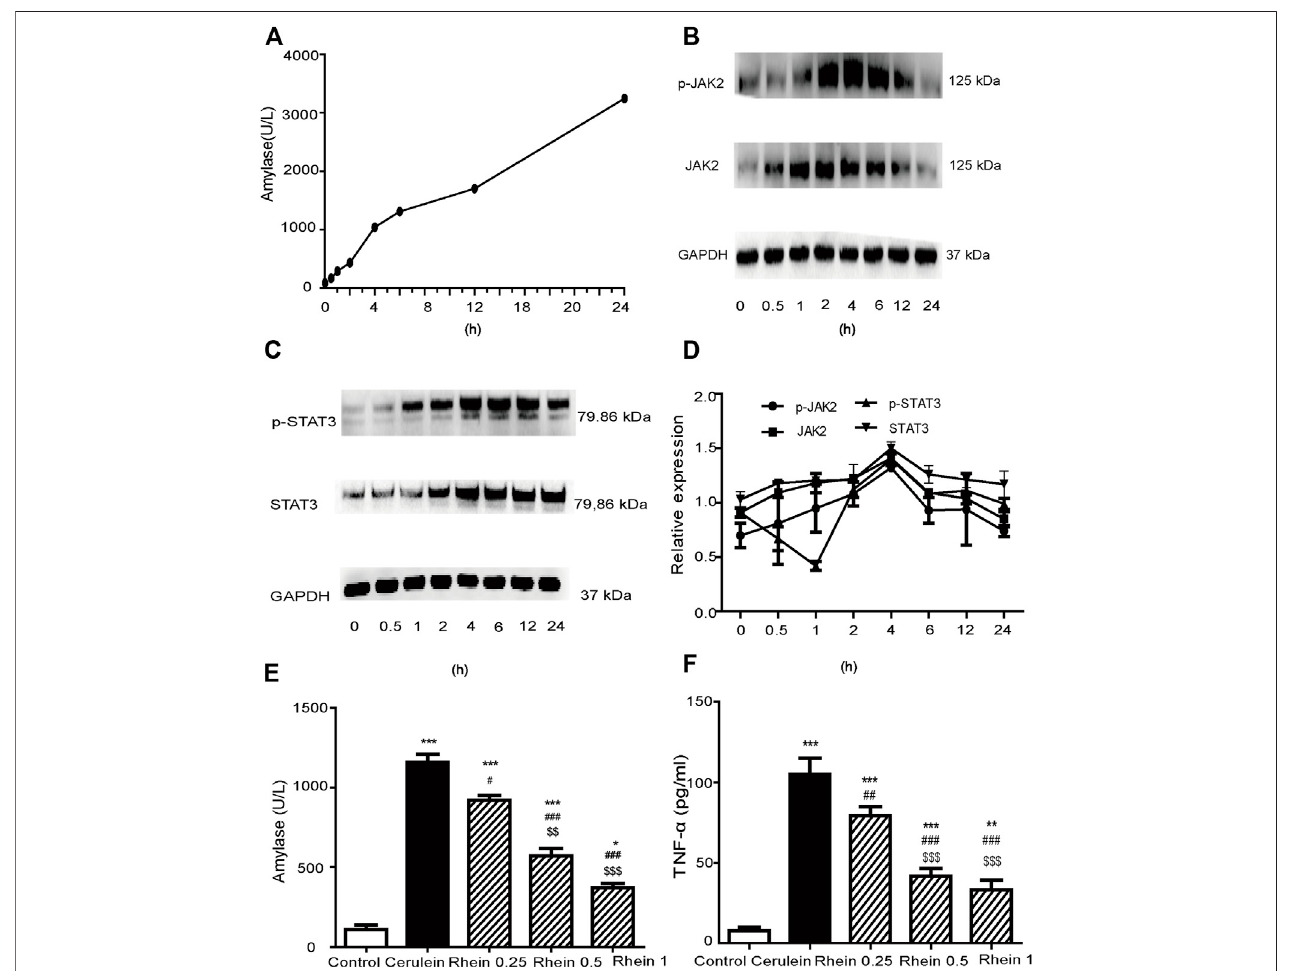
FIGURE7| AR42Jcellinjurymodelestablishedbyceruleintreatment. (A) Theamylaseactivitywasmeasuredatdifferenttimepoints. (B,C) Westernblot fi ndingsof p-JAK2, JAK2, p-STAT3 and STAT3 protein expression in AR42J cells treated with cerulein. (D) Peak of p-JAK2, JAK2, p-STAT3 and STAT3 proteins expression at different simultaneous phase sites. (E) amylase activity in the control, cerulein, rhein 0.25 μ g/ml, rhein 0.5 μ g/ml and rhein 1 μ g/ml groups (F) The TNF- α levels in the control, cerulein, rhein 0.25 μ g/ml, rhein 0.5 μ g/ml and rhein 1 μ g/ml groups. Data are expressed as mean ± SD ( n = 5 per group). Signi fi cance between groups was evaluated by one way analysis of variance (ANOVA) followed by a Tukey post hoc test. JAK2, janus kinase two; STAT3, signal transducer and activator of transcription 3.